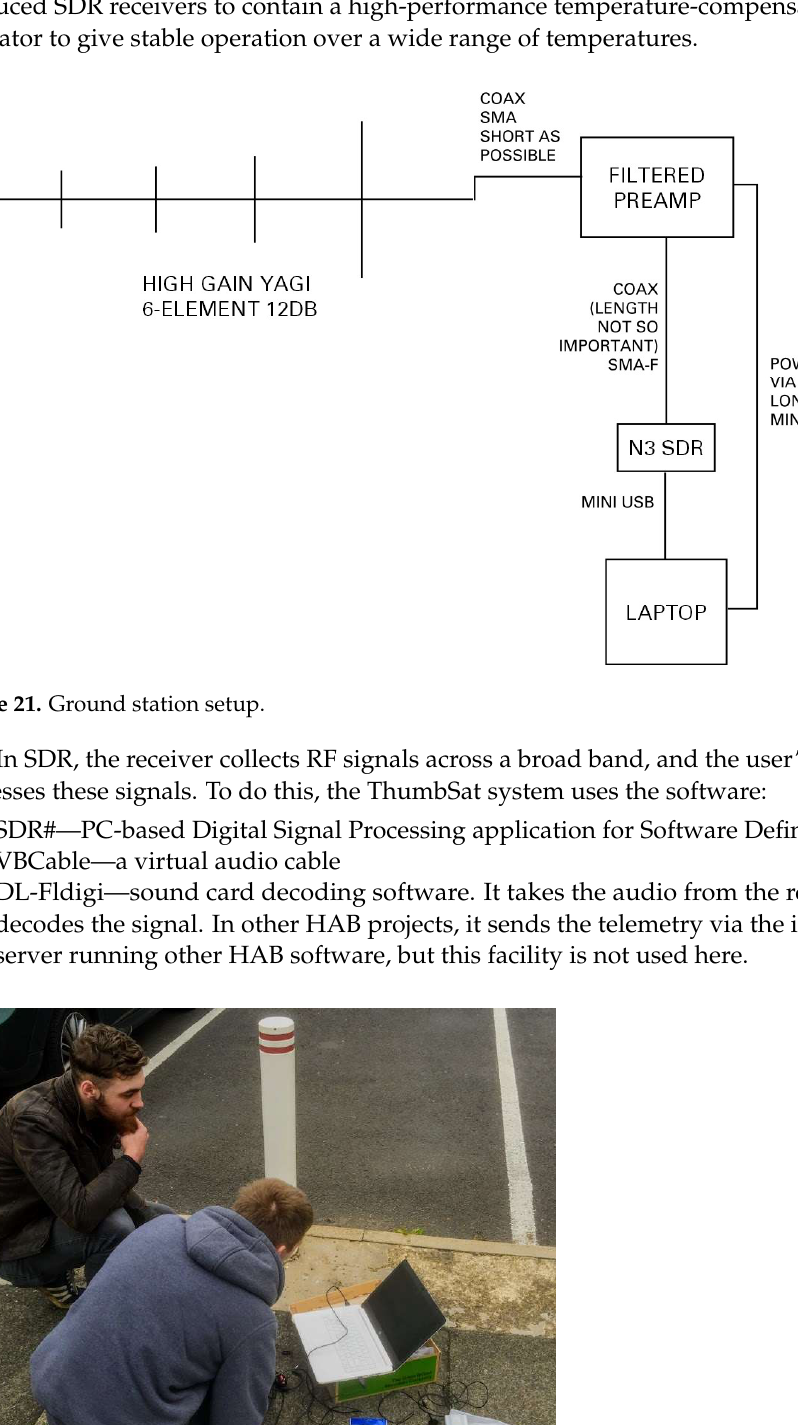
Figure 20. Component carrier, with MOSFET, SMA wires and pinpuller visible at top, ThumbSat at lower right, ¼ wavelength monopole antenna (yellow) in the centre.